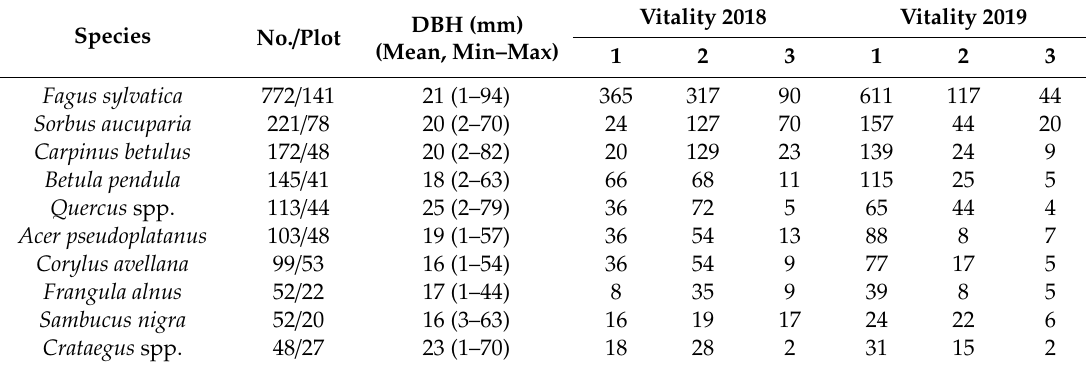
Table 1. Ten most abundant tree saplings measured in 2018 and 2019 (1777 individuals) for their diameter at breast height (DBH) and vitality (1 = undamaged, 2 = partly damaged, 3 = completely damaged).